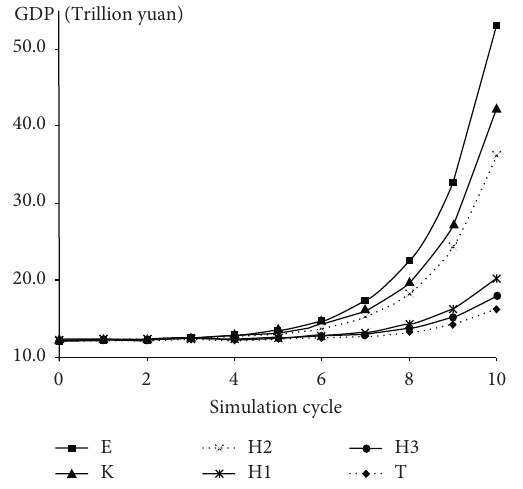
Figure 2: Simulation results of the effect of factor input on eco- nomic